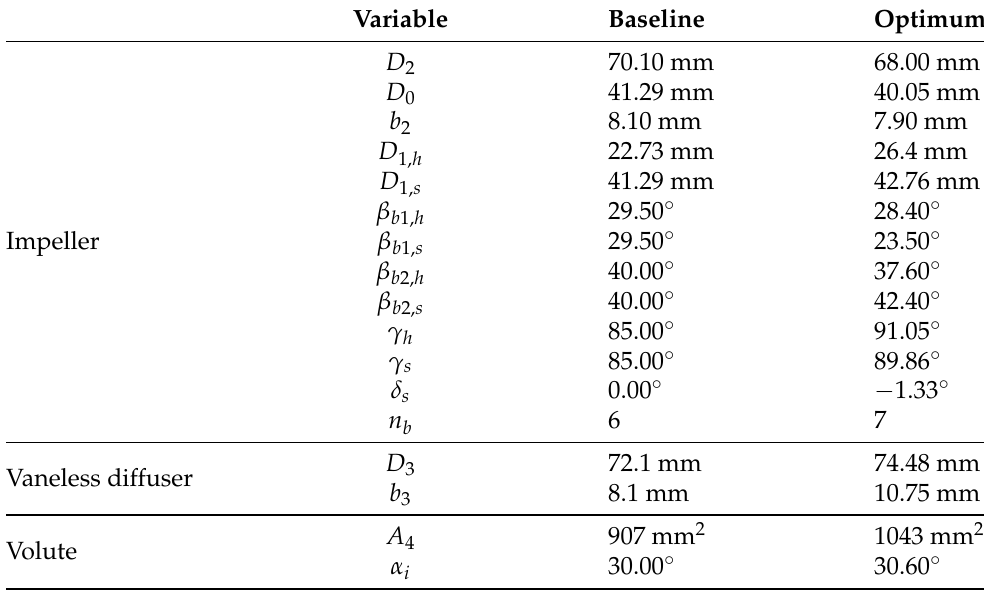
Table 5. List of the geometrical parameters for the baseline and optimized geometries provided by the LP code and the SBO algorithm,